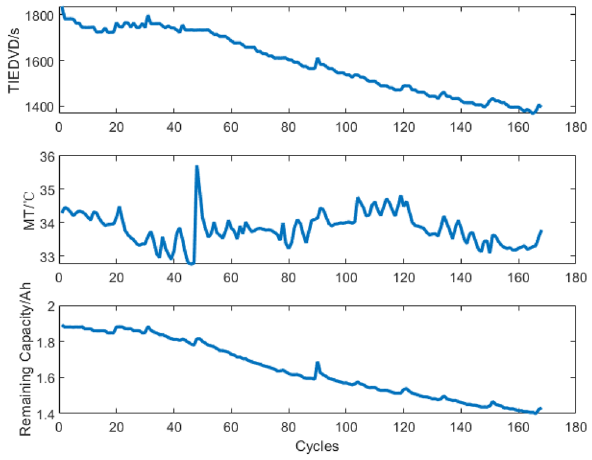
Fig. 4 The ageing conditions of TIEDVD, MT, and capacity In addition, B7’s TIEDVD, MT, and capacity changes over time are shown in Fig. 4.